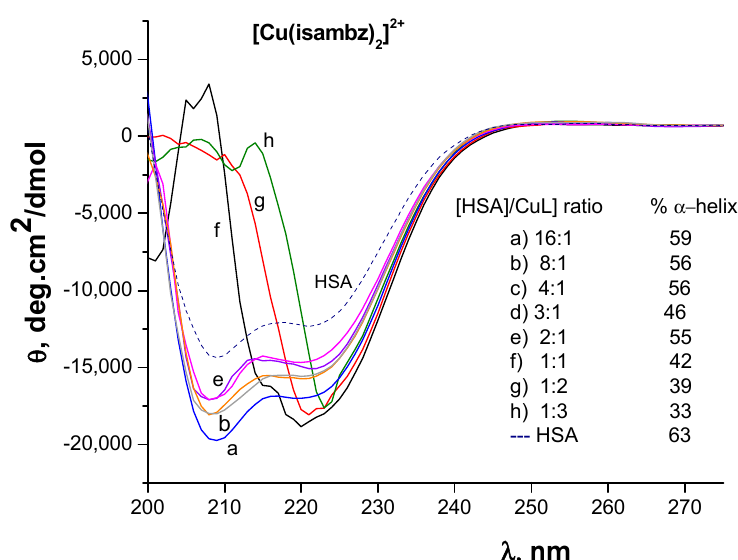
Figure 4. CD spectra registered (double scanning) after increasing concentrations of complex 1 (0.15 to 7.5 µ M), to HSA solution (2.5 µ M), in phosphate buffer 50 mM containing 0.10 M NaCl, at pH 7.4, at room temperature.